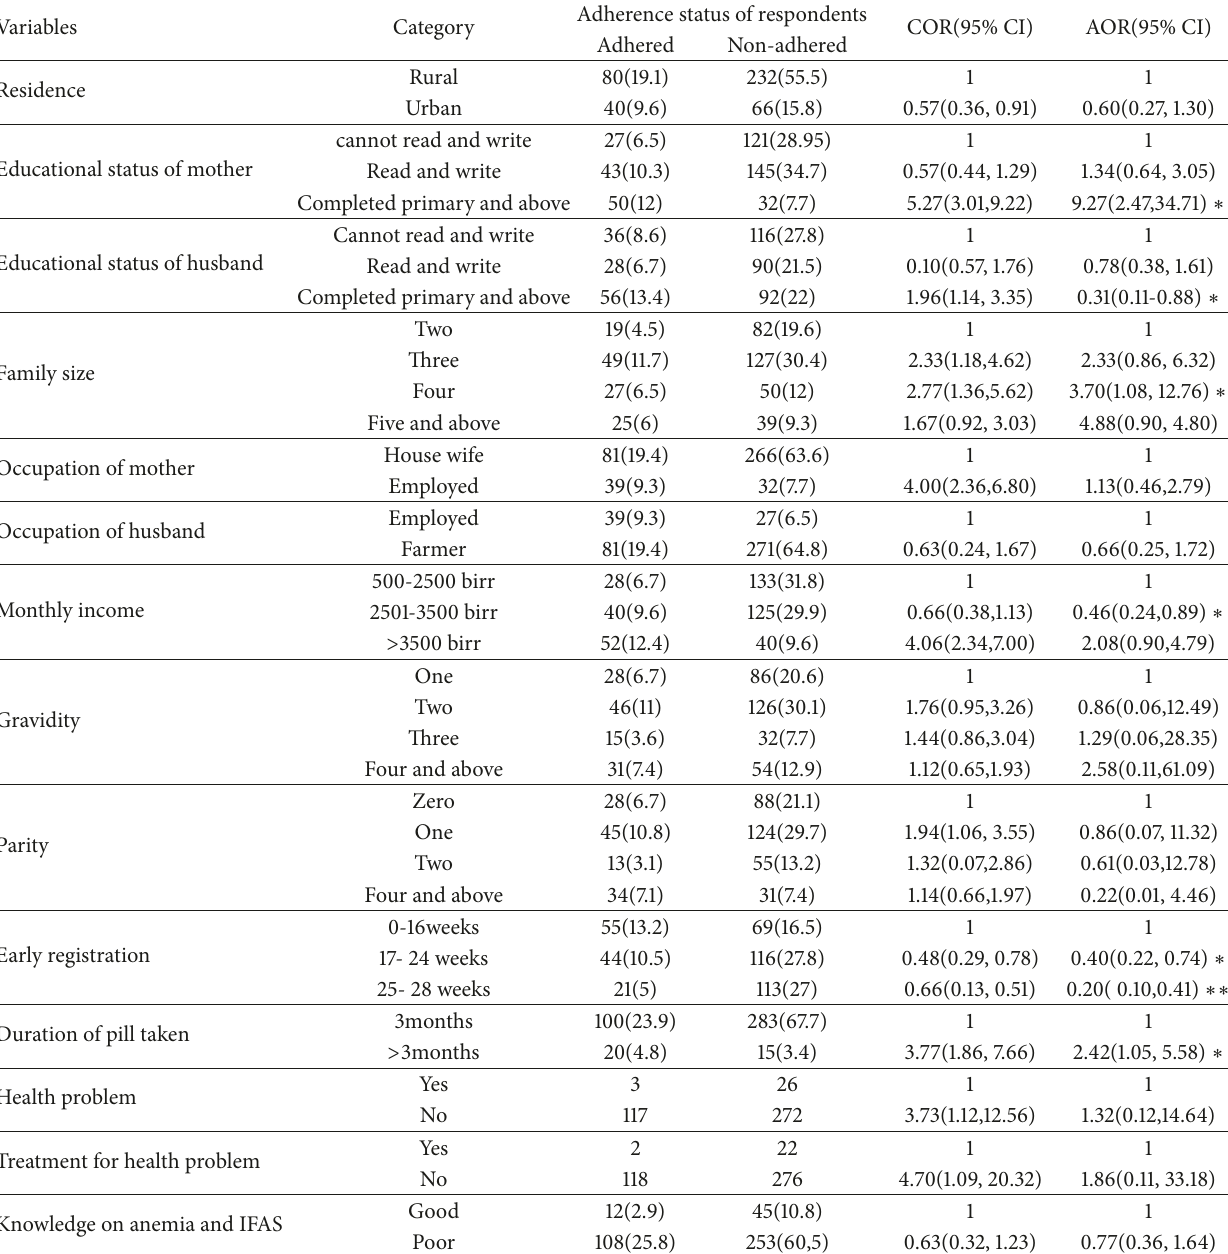
Table 5: Factor associated with adherence Lay Armachiho district Health Centers, Northwest Ethiopia, 2017